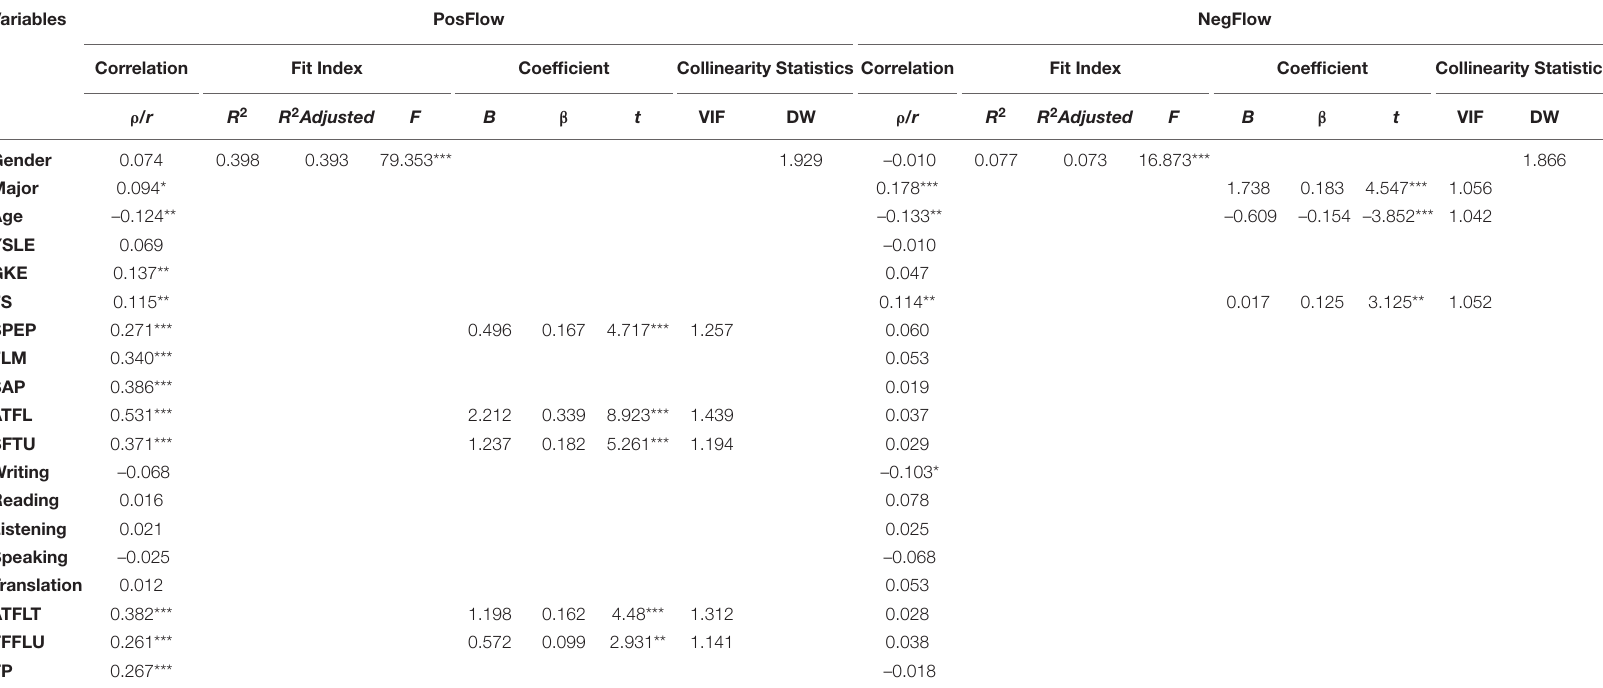
TABLE 2 | Inter-correlations between independent variables and regressions predicting PosFlow and NegFlow.